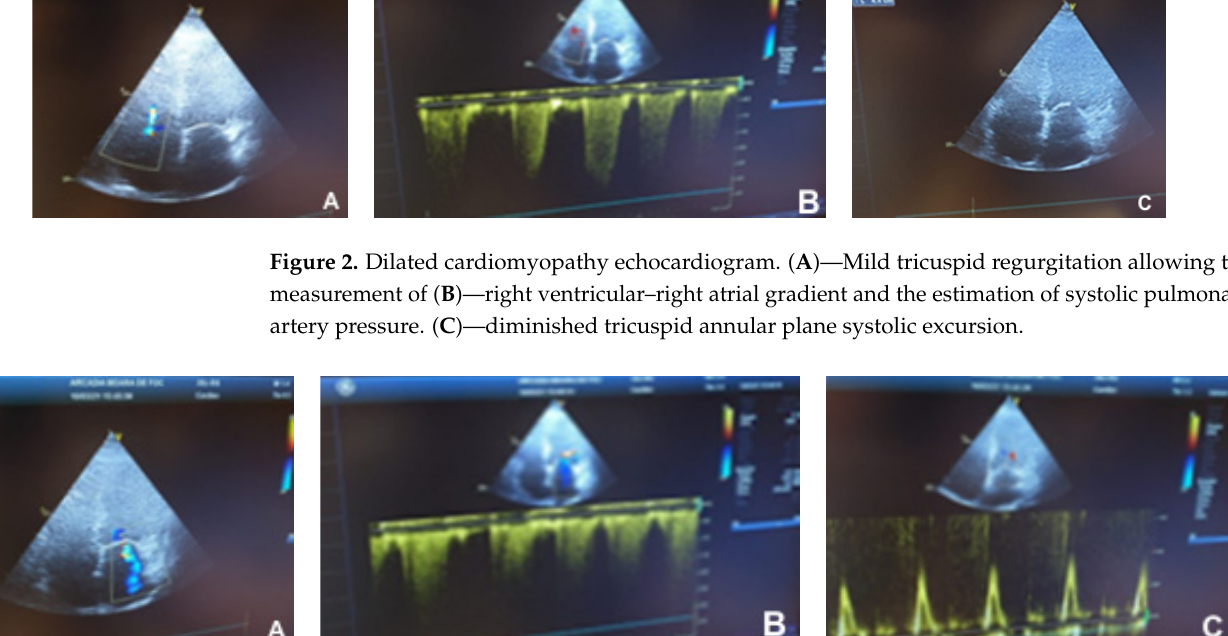
Figure 3. Dilated cardiomyopathy echocardiogram. ( A )—Severe mitral regurgitation (apical four- chamber); ( B )—tricuspid envelope continuous Doppler; ( C )—trans-mitral pattern that is suggestive of atrial fibrillation.